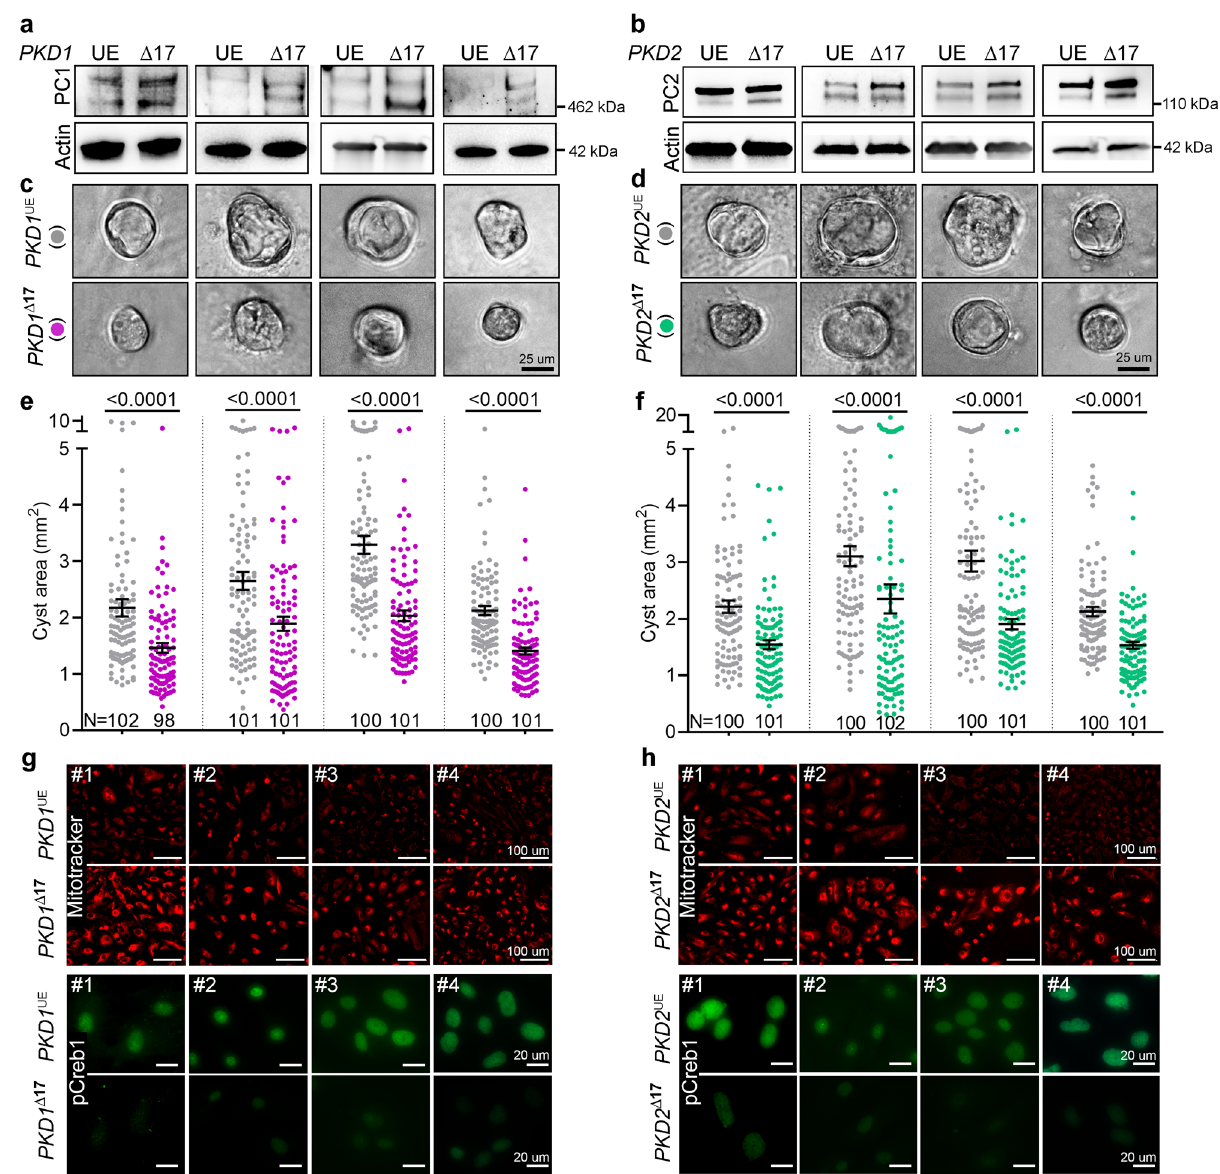
Fig. 6 | PKD1 Δ 17 or PKD2 Δ 17 reduce 3D cyst growth in primary human ADPKD cultures. CRISPR/Cas9-editing was used to delete the miR-17 motif from PKD1 3 ′ - UTR ( PKD1 Δ 17 ) or PKD2 3 ′ -UTR ( PKD2 Δ 17 ) in primary ADPKD cultures from four humandonors(#1through#4). a , b ImmunoblotsshowinghigherPC1expressionin PKD1 Δ 17 and higher PC2 expression in PKD2 Δ 17 ADPKD cultures compared to their respective unedited (UE) parental ADPKD cultures. Protein bands are 460kDa ( a ) and 110 – 120kDa size ( b ). Actin serves as the loading control. c – f Images and